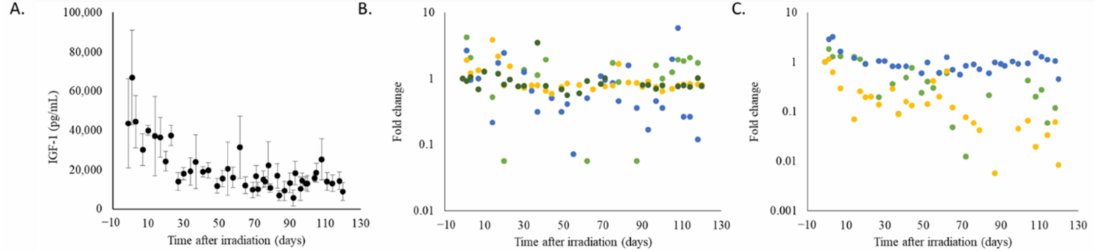
Figure 4. Analysis of plasma IGF-1 levels in irradiated animals by ELISA. ( A ) Values are shown as averages +/ − sem over time. ( B ) Data from individual animals were normalized to pre-irradiation levels and grouped by radiation dose; 1.9 Gy ( n = 4 animals, individual measurements for a given animal are represented by data points of a single color: dark green, blue, green, or yellow) and ( C ) 2.0 Gy ( n = 3 animals, individual measurements for a given animal are represented by data points of a single color: blue, green, or